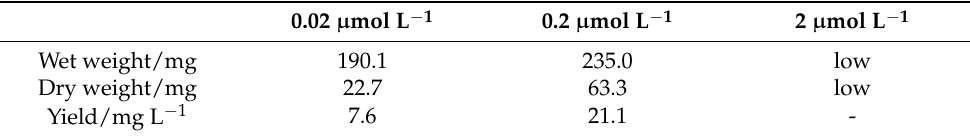
Table 2. Yields of magnetosomes by fermenter culture under different iron